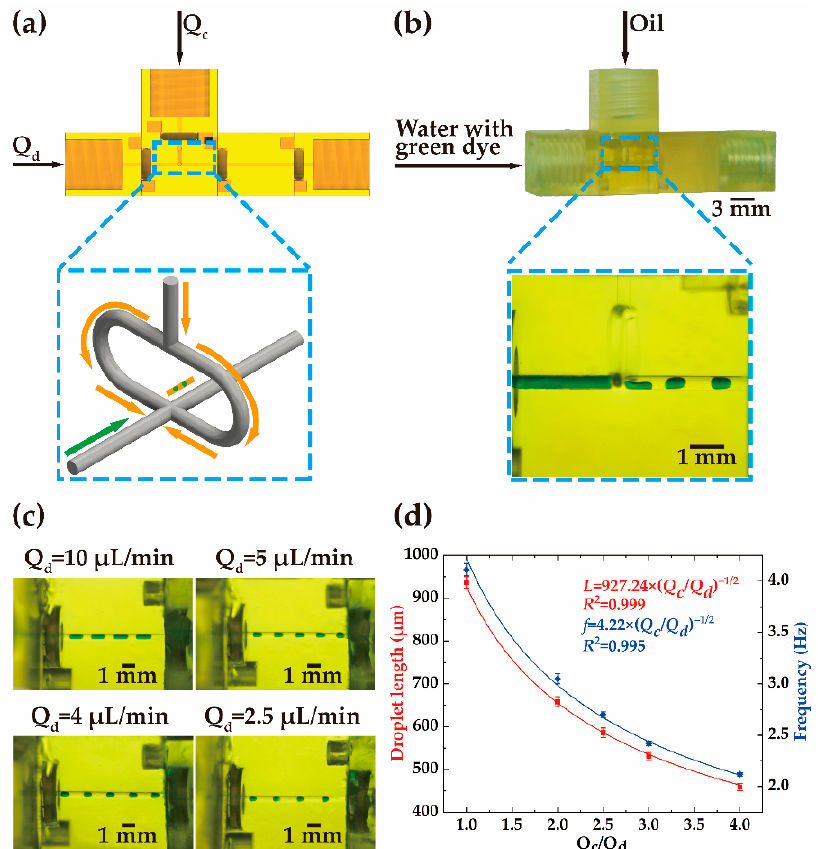
Figure 3. Schematic illustration of single-droplet generation. ( a ) Schematic and ( b ) the printed sample of assembled passive single-droplet generation device, respectively. ( c ) Optical micrographs of the produced single droplet at four flow rates of the discrete phase with the same flow rate (10 µ L/min) of the continuous phase. ( d ) The plot of the flow rate ratio ( Q c / Q d ) versus the droplet length at different flow rates and the frequency of the droplet generation.